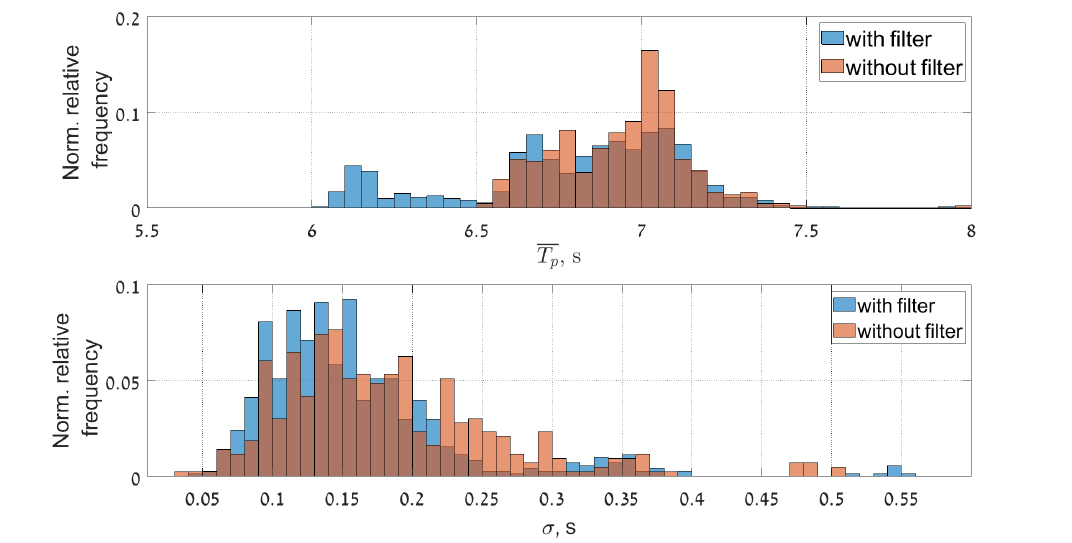
Figure 15. Normalized histograms of the mean values of the T p and its standard deviation given in a relative fraction to the total number of points, bin width for mean value is 0.05 s and for standard deviation 0.01 s.